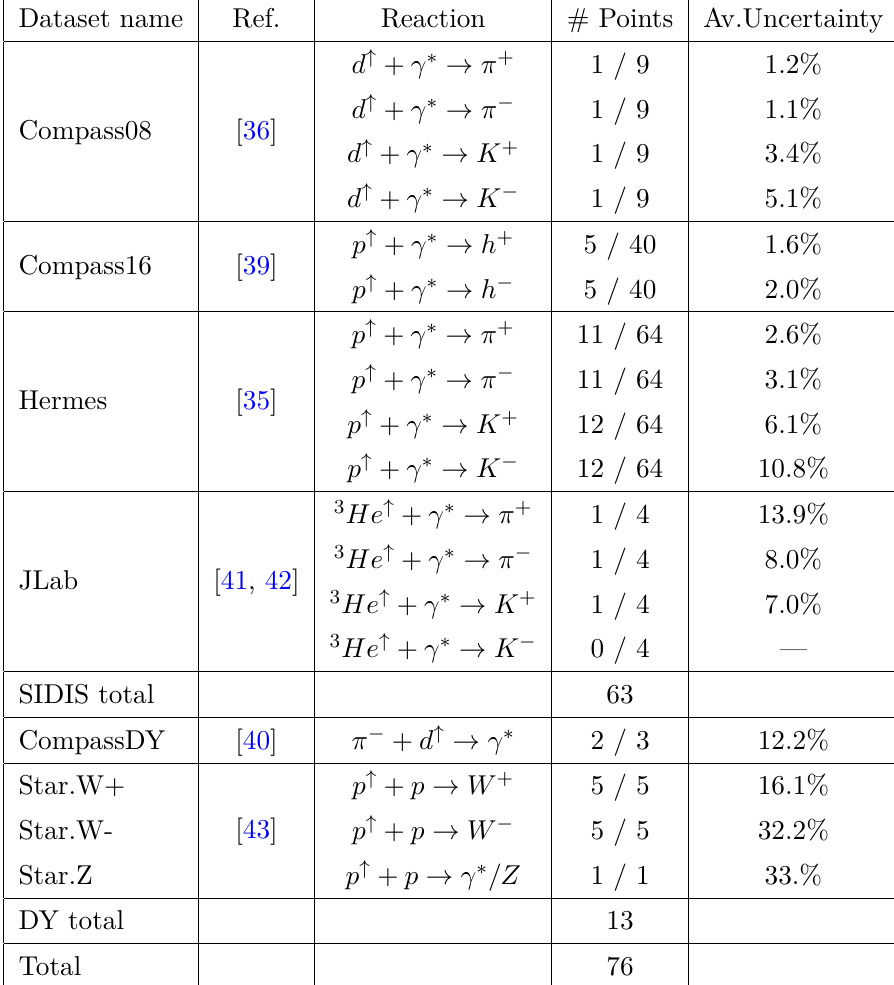
Table 1. Synopsis of the data sets used in the analysis. The fourth column “# Points” shows the number of data points selected after application of cuts from eq. (3.2) and the total number of available data points. The last column shows the average uncorrelated error for points in the data set (after application of